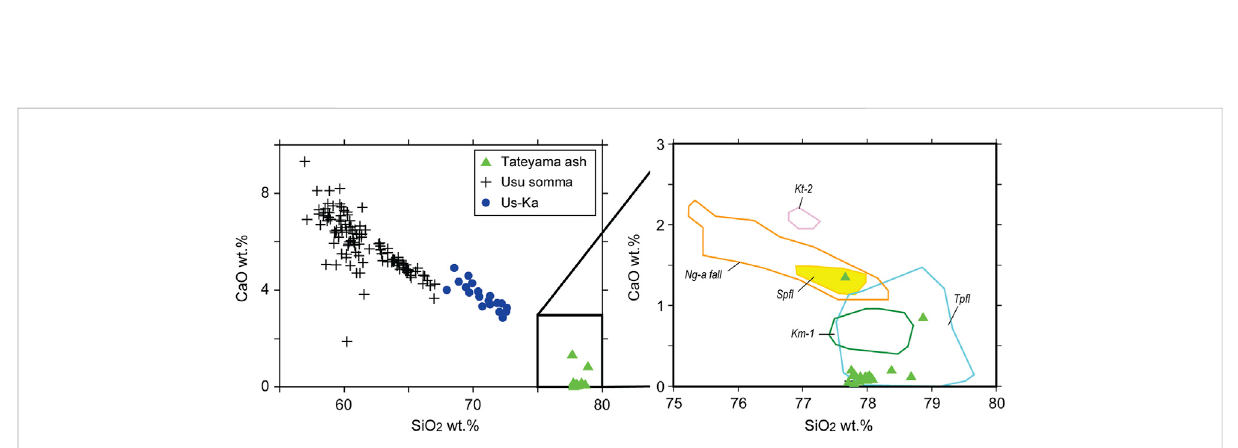
FIGURE 11 SiO 2 vs. CaO diagrams showing the chemical compositions of glass shards from the Us-Ka tephra, the Usu somma tephra, and the Tateyama ash. Most glass shards of the Tateyama ash are correlated to those of the Tp fl